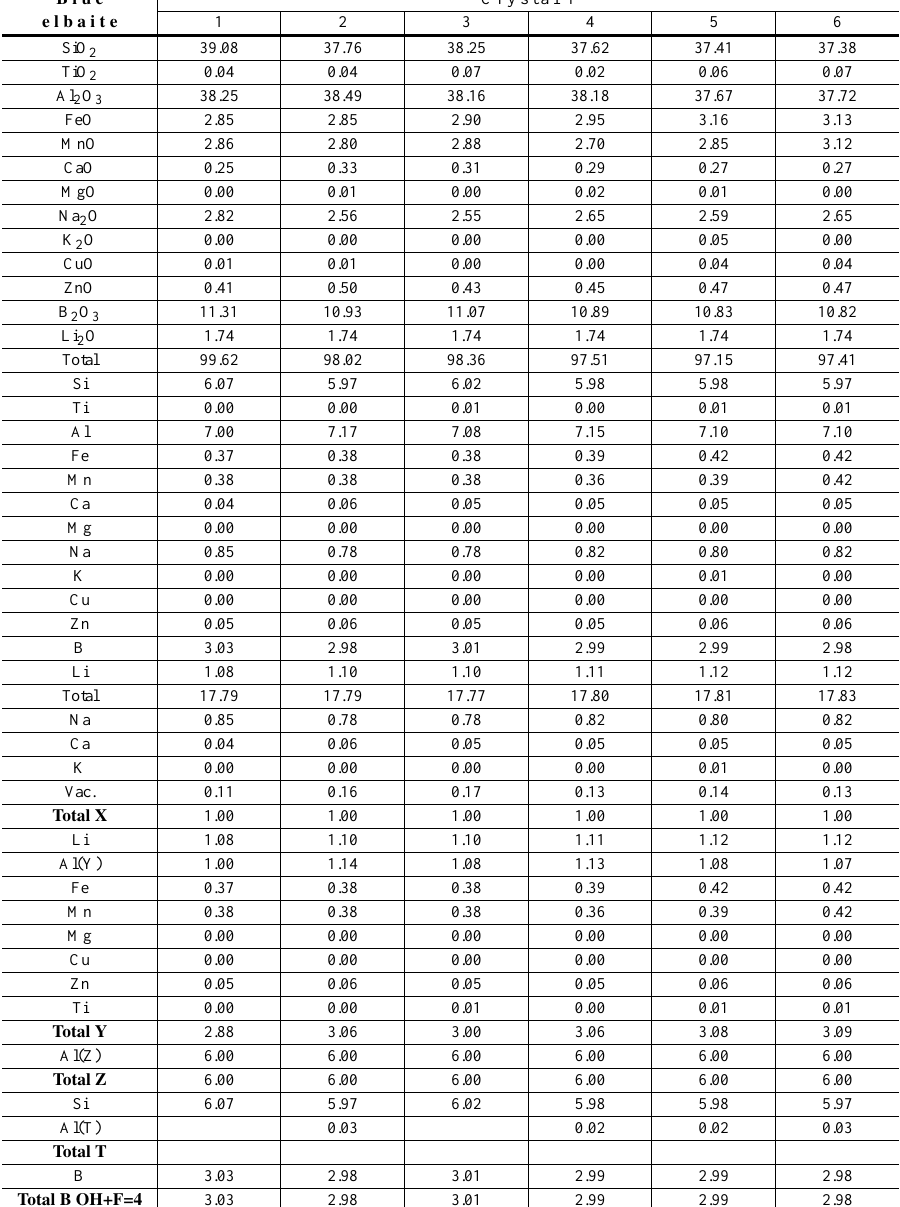
Electron microprobe analyses of blue and green elbaites from the Alto Quixaba pegmatite, northeastern Brazil. Structural formulae calculated on the basis of 29 oxygens, assuming a complete occupation of 4 anions in the hydroxila site. Li 2 O contents analyzed by